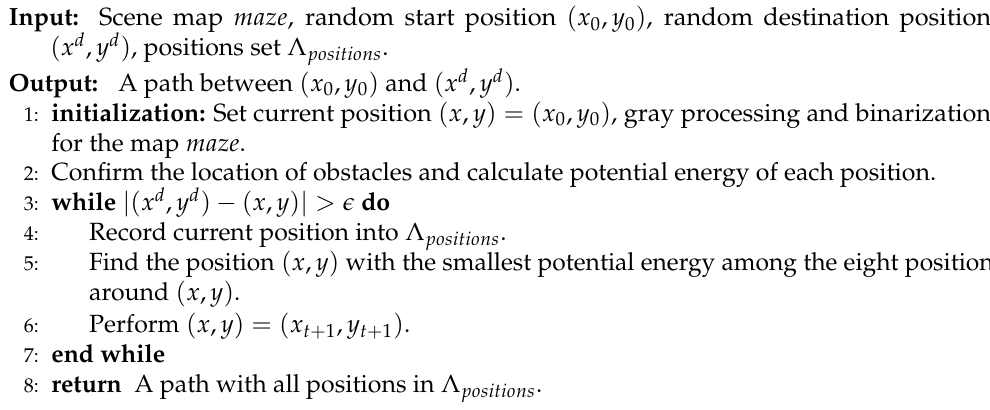
Algorithm 3 APF method implementation